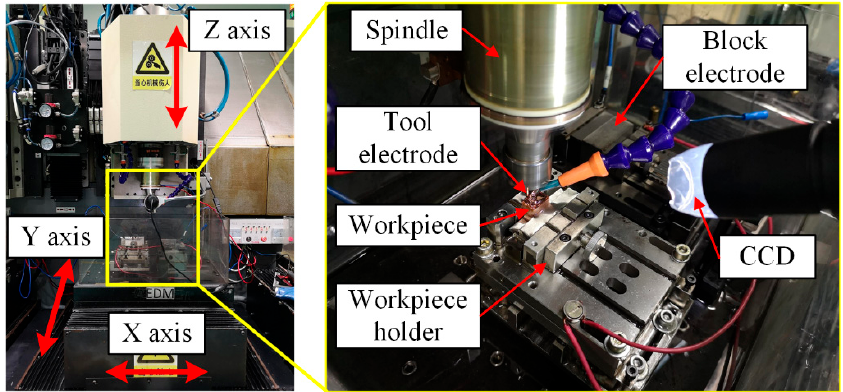
Figure 12. Photo of the experimental apparatus. Table 2. Material properties.